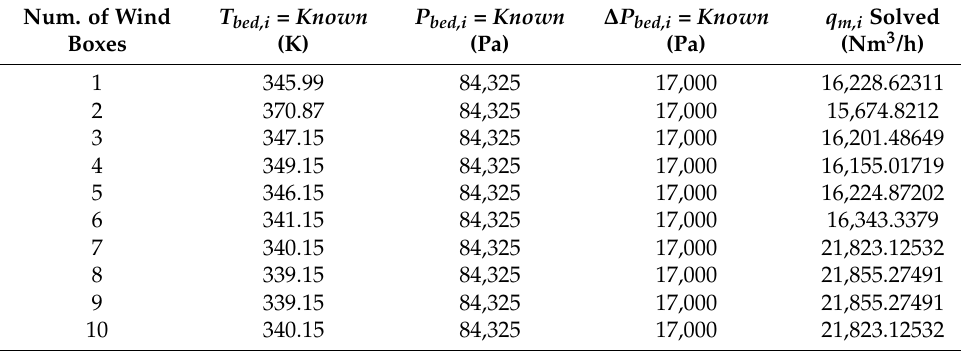
Table 2. The parameters of each wind box’s